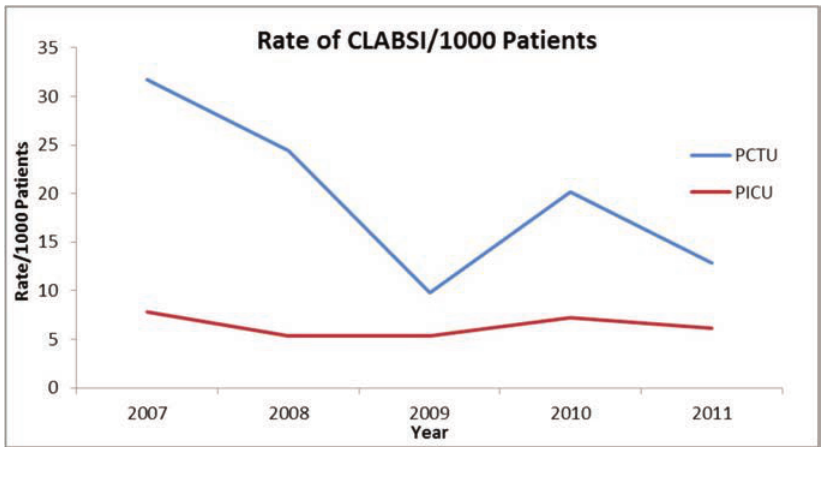
Figure 1. Rate of central line associated bloodstream infections per 1000 patients in the Pediatric Intensive Care Units and Pediatric Cardiothoracic Intensive Care Unit by year from 2007 to